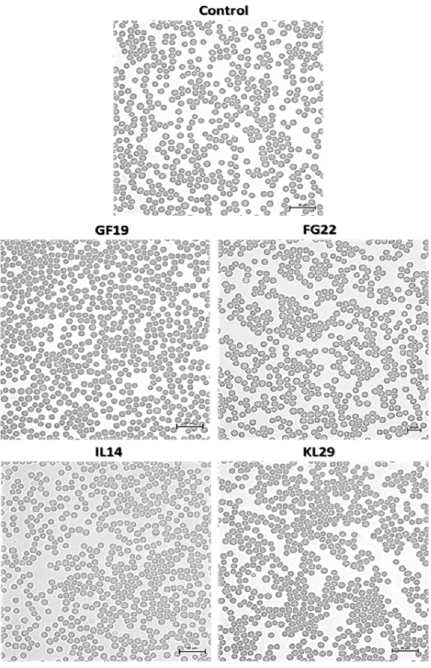
Figure 7. Horse erythrocytes challenged to selected antimicrobial peptides at 250 µM for 3 h, show- ing normal cells structure. Control: Untreated-erythrocyte cells. Bar = 20 µm.